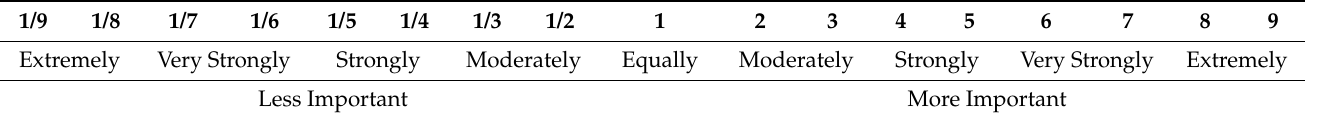
Table 3. The relative importance of two